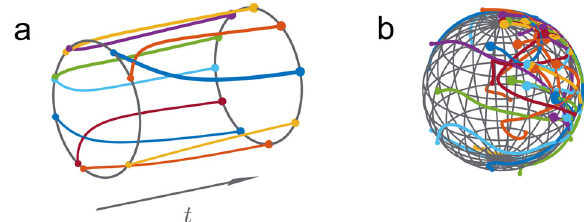
Fig. 1 Spaghetti plots of agent trajectories. Initial and end con fi gurations are indicated by small and large dots, respectively. a 10 agents of the homogeneous model, Eq. (3), on the circle S 1 , converge to a 1-twisted state (a dispersed equilibrium) from a random initial condition, see Eq. (6). b 20 agents of the heterogeneous model, Eq. (2), on the sphere S 2 converge to practical synchronization from initial conditions given by a dodecahedron con fi guration.